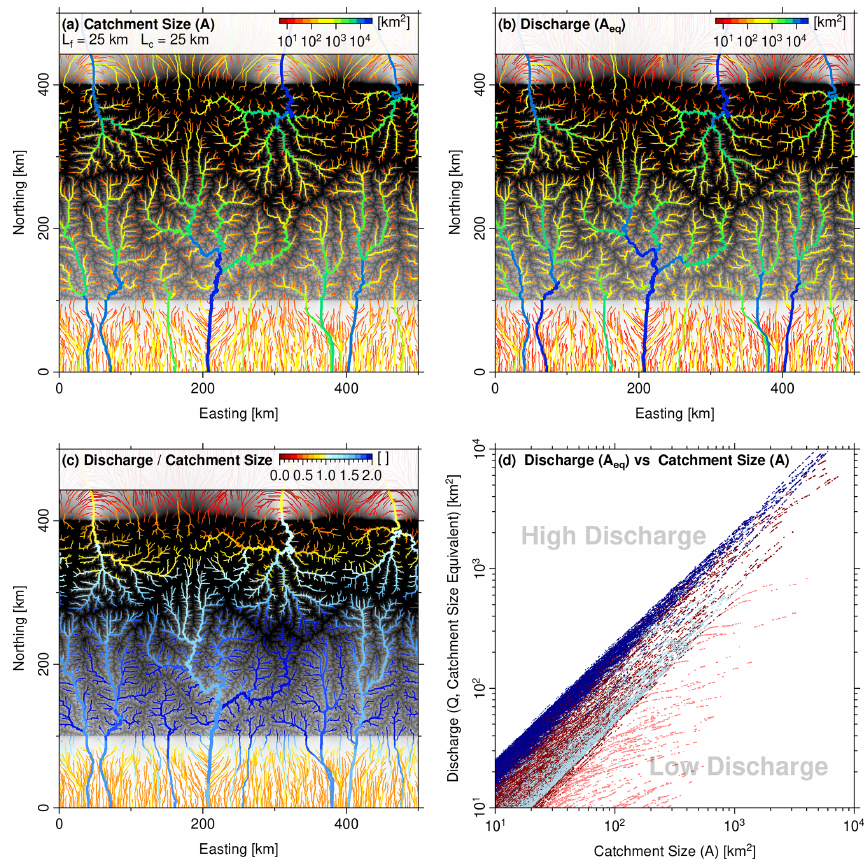
Figure 12. Spatial distribution of precipitation and discharge for U = 1 . 5kmMyr − 1 , K = 2 . 5Myr − 1 , L l = 500km, L c = L f = 25km, L d = 5km, and (cid:15) = 0 . 5. The topography and precipitation pattern of this scenario is shown in Fig. 9 (right-hand column). Channels are color-coded for (a) contributing drainage area and (b) river discharge as catchment-size equivalent A eq . (c) Ratio of discharge A eq and catchment size A . All channels with a catchment size A ≥ 25km 2 are considered. (d) Relationship between catchment size and discharge at the windward (blue dots) and the leeward (red dots) side of the mountain range. Dark colors represent the mountain range and light colors the